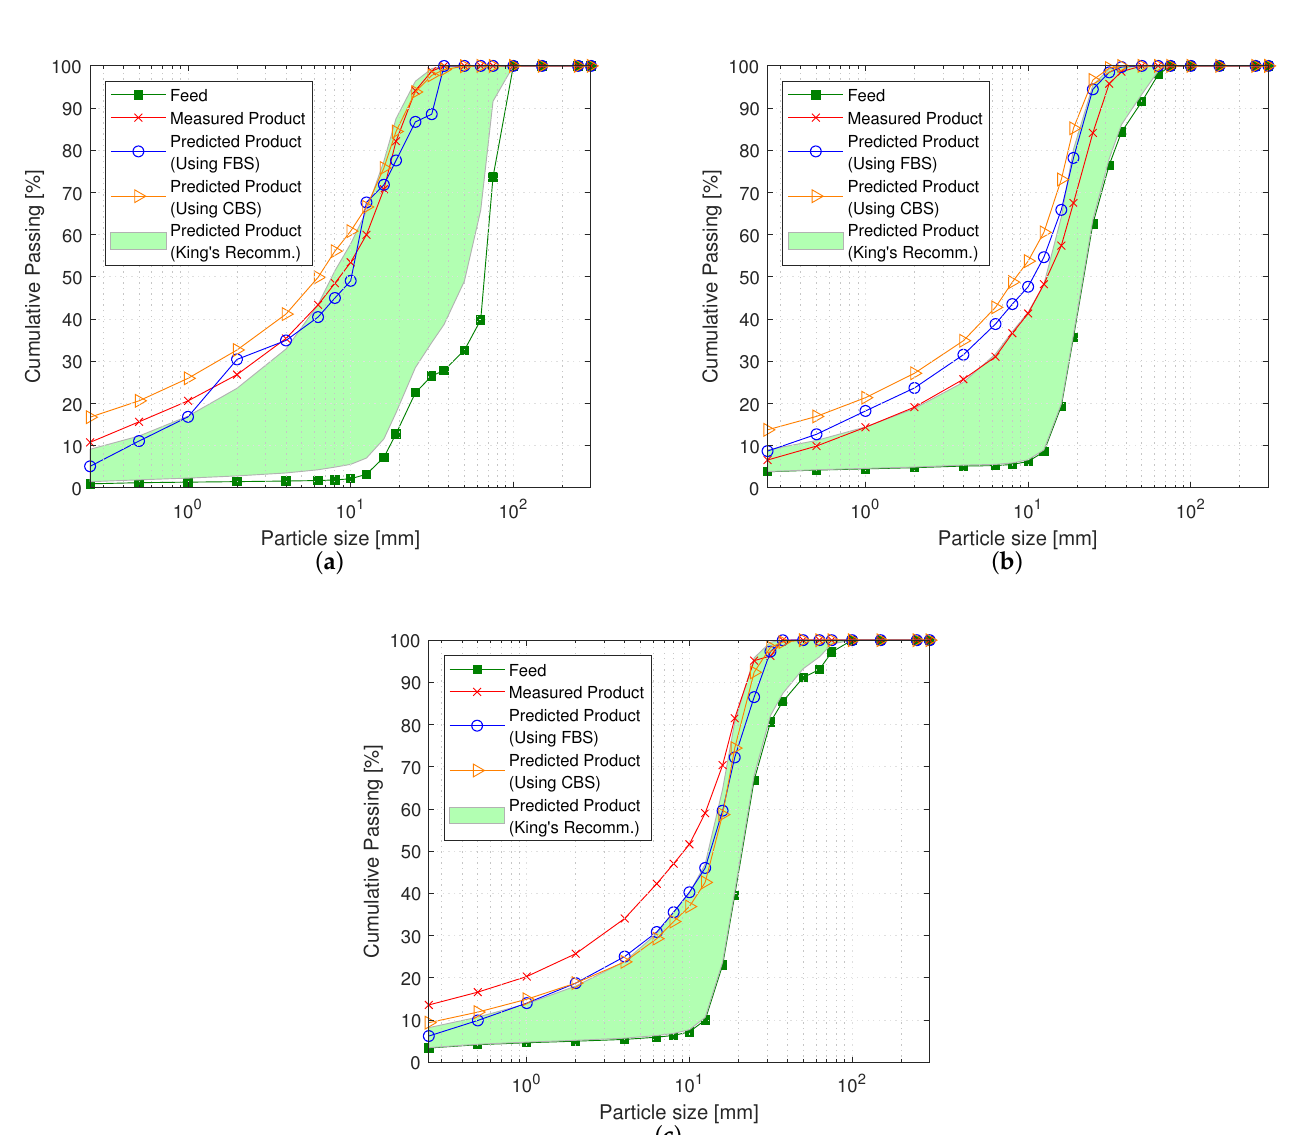
Figure 8. Measured and predicted PSD curves in Scenario 2 for the S11D datasets. ( a ) PSD predicted using the model calibrated on datasets 4 and 7. Validation with Dataset 5. ( b ) PSD predicted using the model calibrated on datasets 4 and 5. Validation with Dataset 6. ( c ) PSD predicted using the model calibrated on datasets 5 and 6. Validation with Dataset